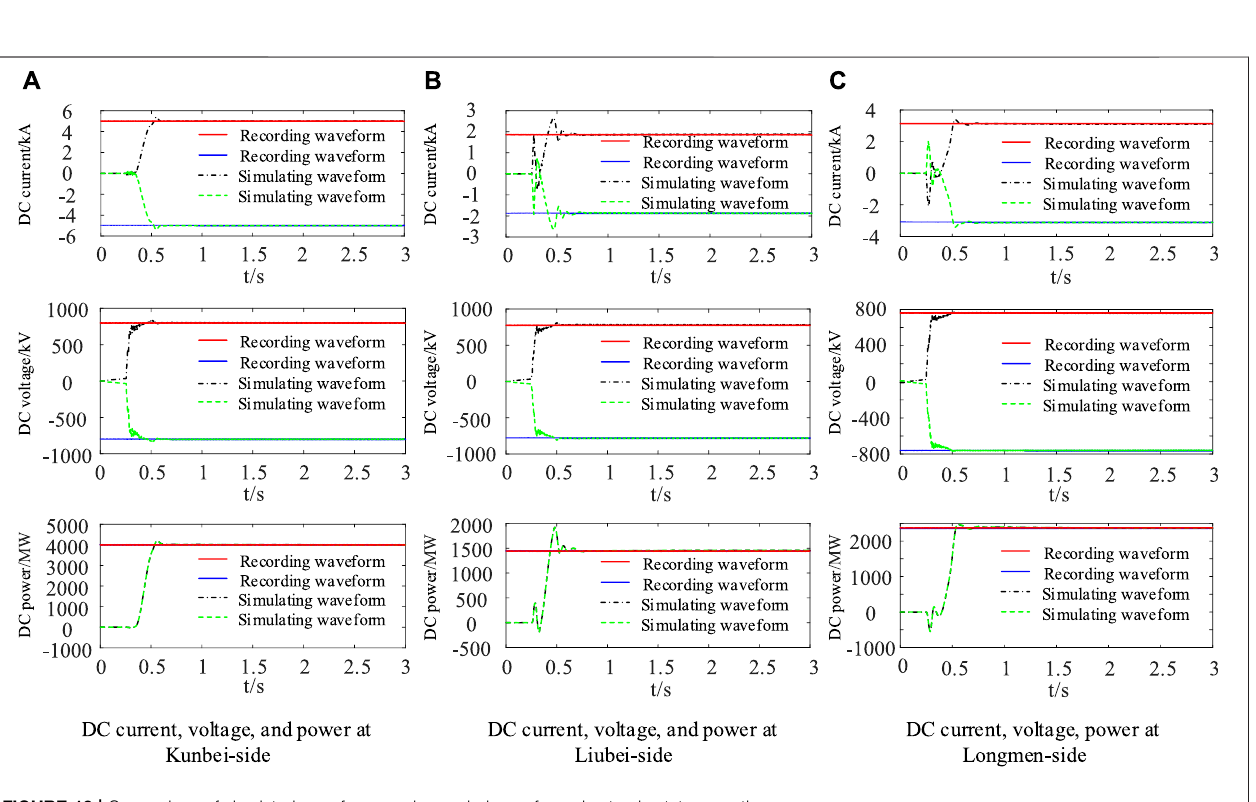
Frontiers in Energy Research |